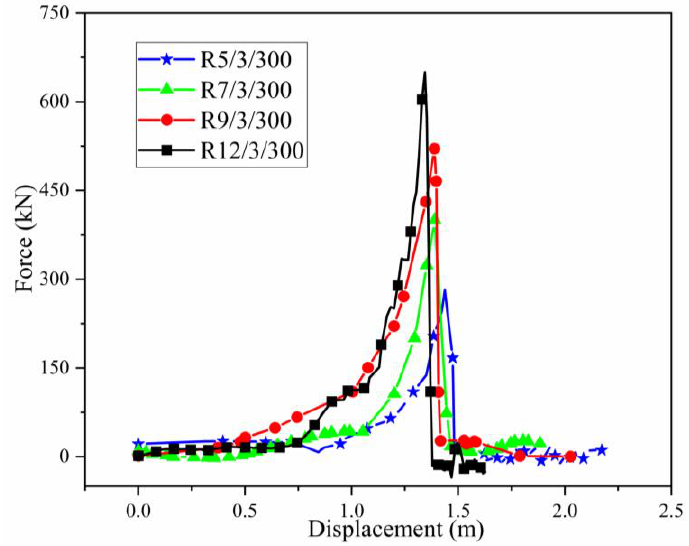
Figure 8. Force displacement curves of the ring net with different specifications. Table 4. Breaking force and breaking displacement of ring nets with different specifications under a dynamic impact condition.